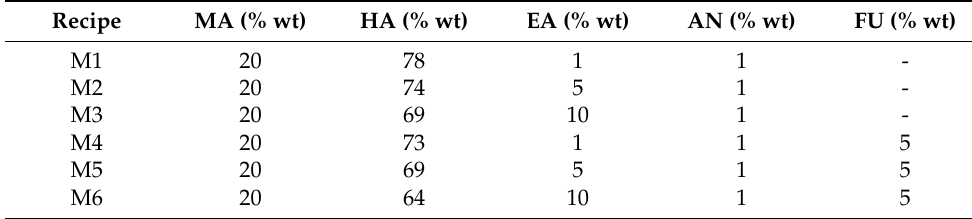
Table 6. The ingredients of the developed